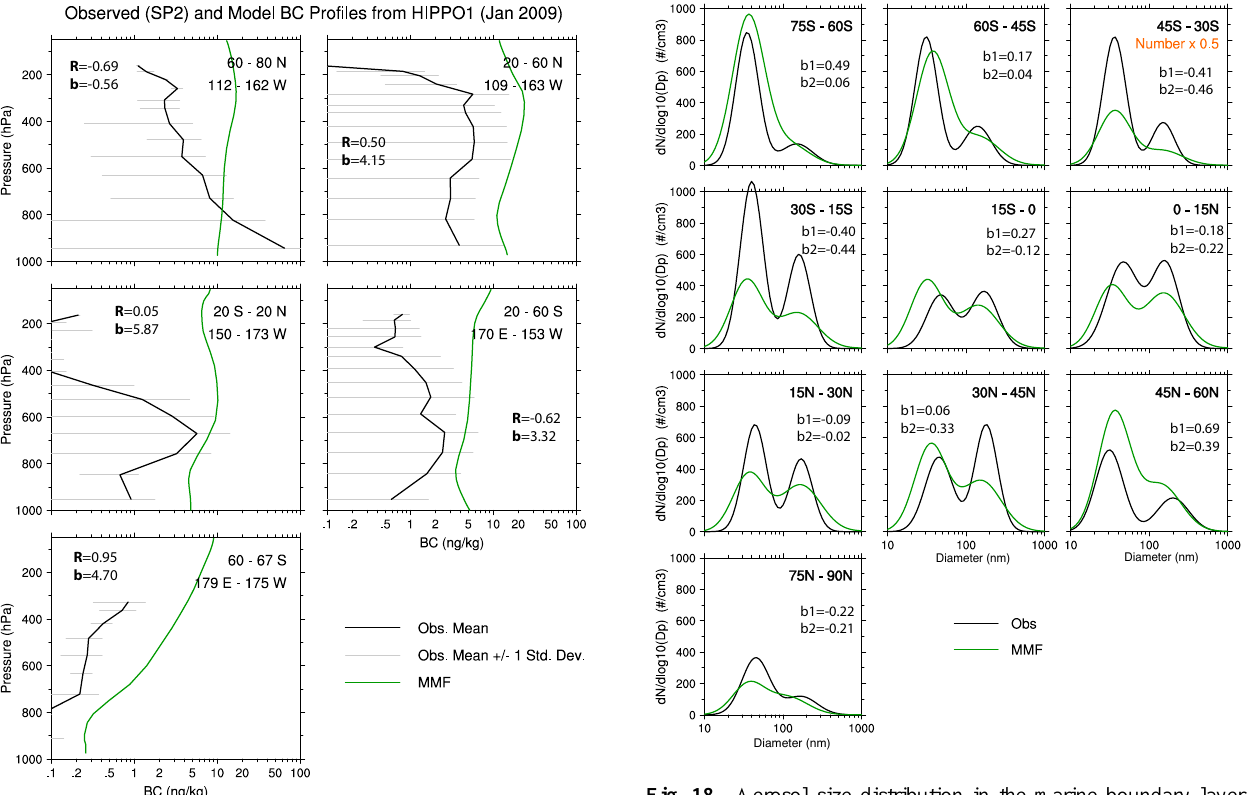
Fig. 18. Aerosol size distribution in the marine boundary layer. Observations (Obs) are from Heintzenberg et al. (2000) and were compiled and aggregated onto a 15 ◦ × 15 ◦ grid. The model data is sampled over the same regions as those of the observations. Annual- mean model data is sampled over the low latitudes (30 ◦ S–30 ◦ N). Over the mid- and high latitudes, the model data are sampled in summer (December–February for the latitude bands of 75 ◦ S–45 ◦ S, November–March for the latitude bands of 45 ◦ S–30 ◦ S, May– September for the latitude band of 30 ◦ N–45 ◦ N, June–August for the latitude bands of 45 ◦ N–90 ◦ N). For the 45 ◦ S–30 ◦ S latitude band, aerosol number density is scaled by 0.5 so the same y axis can be used for all latitude bands. Normalized model bias for the aerosol number concentrations with diameter larger than 10nm (“b1”) and diameter larger than 100nm (“b2”) are shown in each